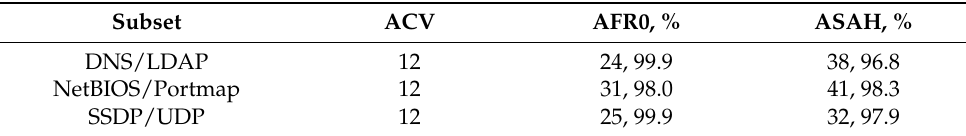
Table 7. Summary of subsets created for labels with strong similarity.